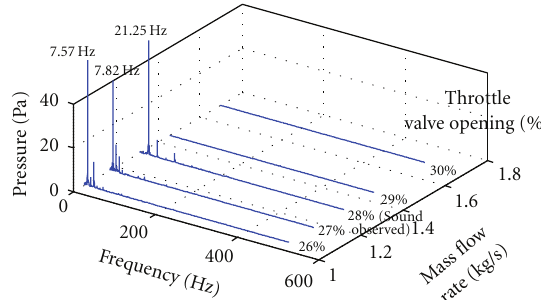
Figure 14: Waterfall plot of the exhaust (discharge plenum) pressure at 16,000